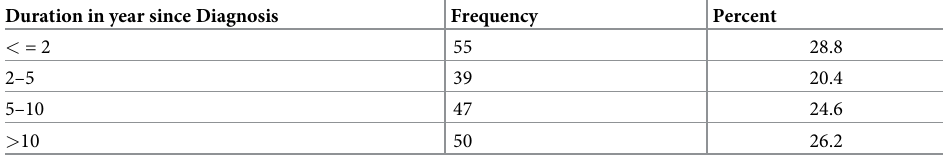
Table 3. Distribution of study participants by duration since the diagnosis of diabetes mellitus among T2DM patients who attend the medical referral clinics for treatment and follow up at DURH,